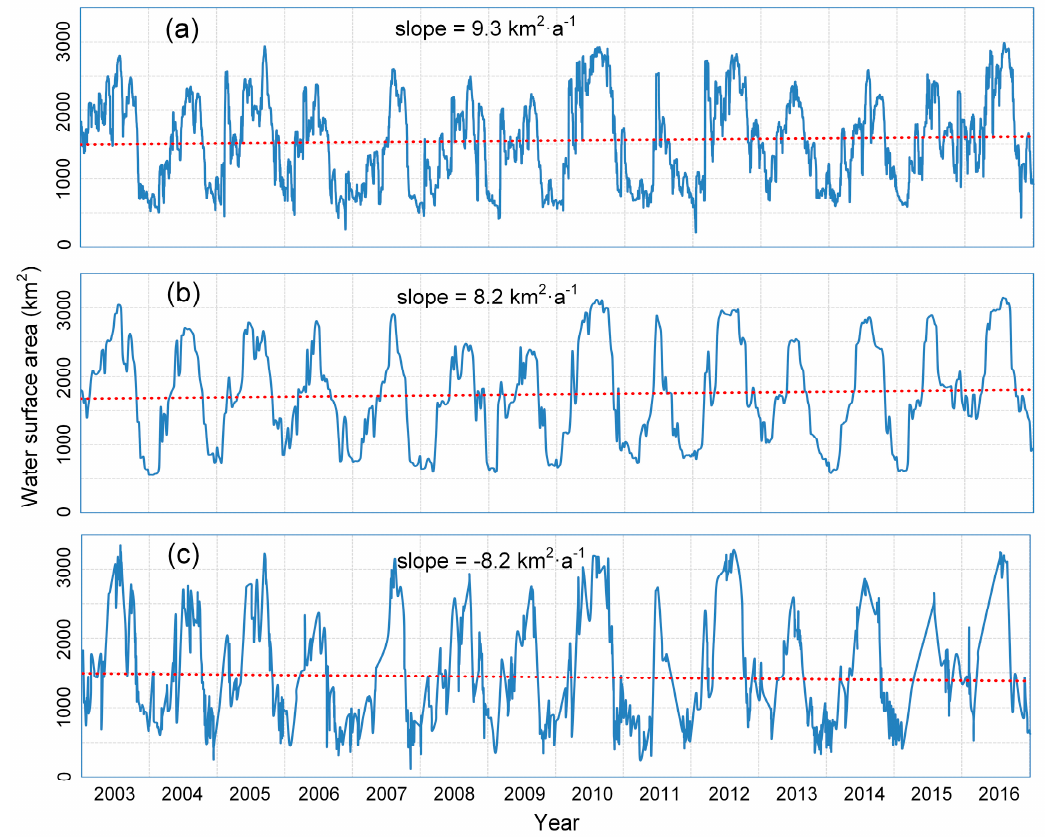
Figure 13. Trends in lake surface area (2003–2016) derived by using ( a ) the MinVC NDVI, ( b ) the Landsat-MOD13 NDVI, and ( c ) the cloud free Terra MODIS NDVI.